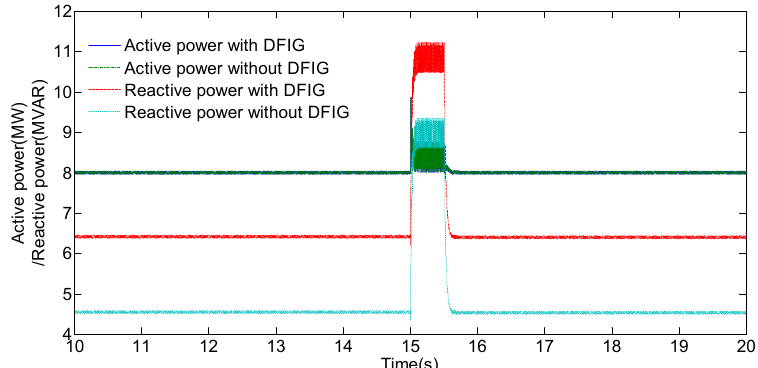
Figure 5. Phase-A currents at node 1 with and without DFIG connected, where an AG fault is applied at node 3.